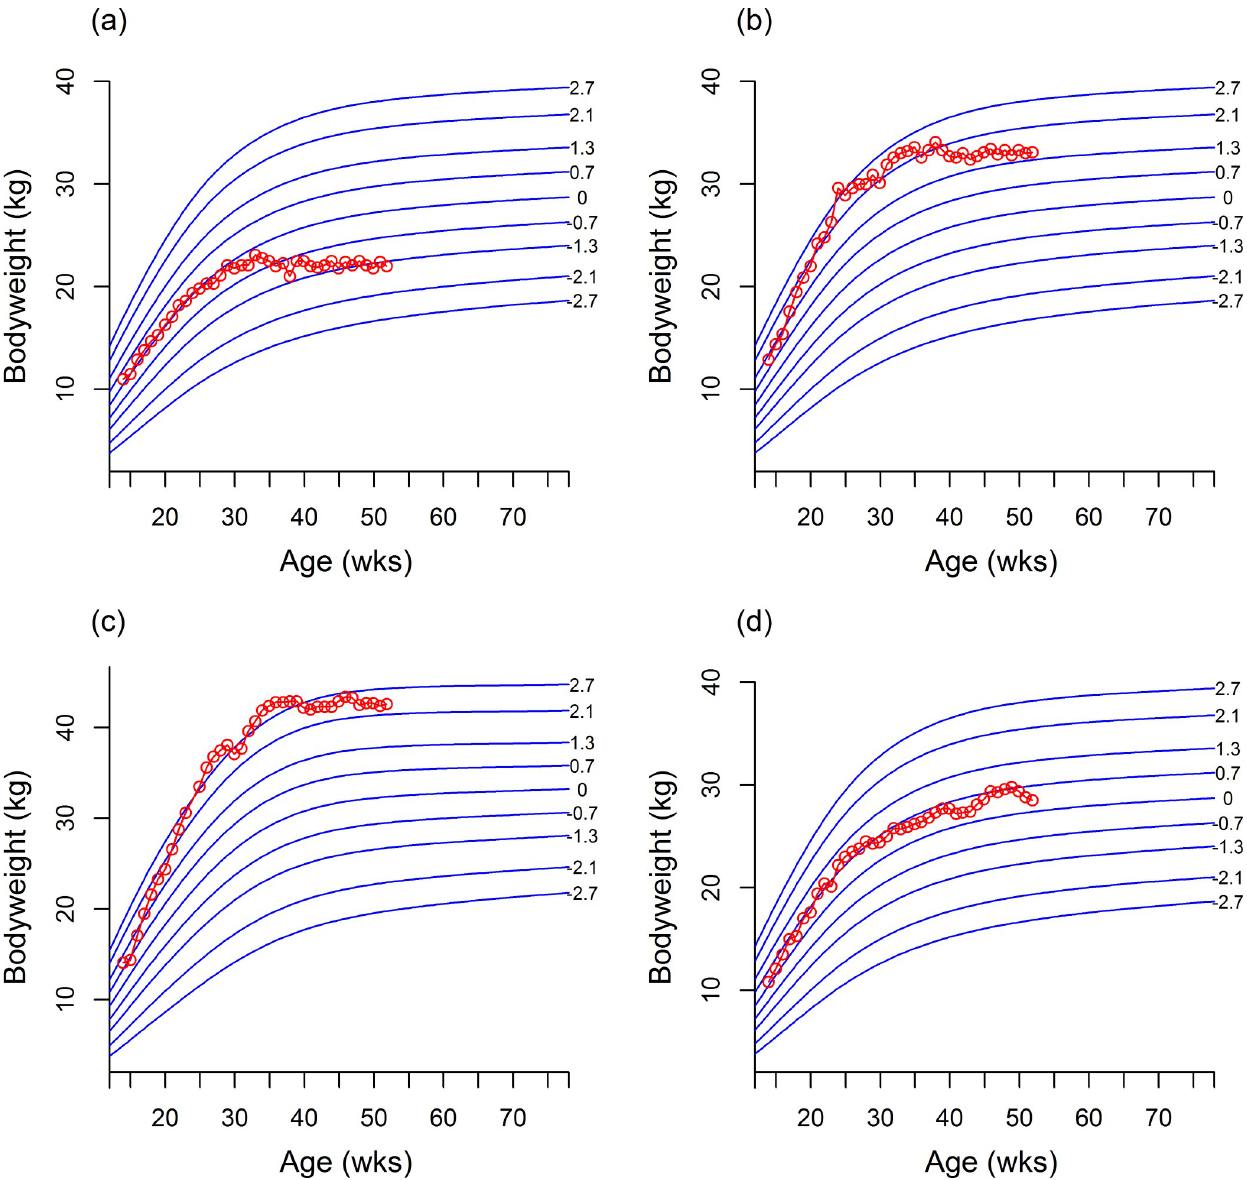
Fig 3. Examples of individual growth trajectories from dogs on restricted and supplemental feeding diets. The red open circles represent weights, whilst the solid blue lines represent the growth centiles for the respective breed size category. (a) A female Labrador Retriever on a restricted diet crossing centile lines on a downwards trajectory. (b) Growth curves from a female Labrador Retriever on a supplemental diet crossing multiple centile lines and (c) a male Labrador Retriever on a supplemental diet crossing centile lines on an upwards trajectory. (d) Growth curve from a female Labrador Retriever on a supplemental diet showing no centile line